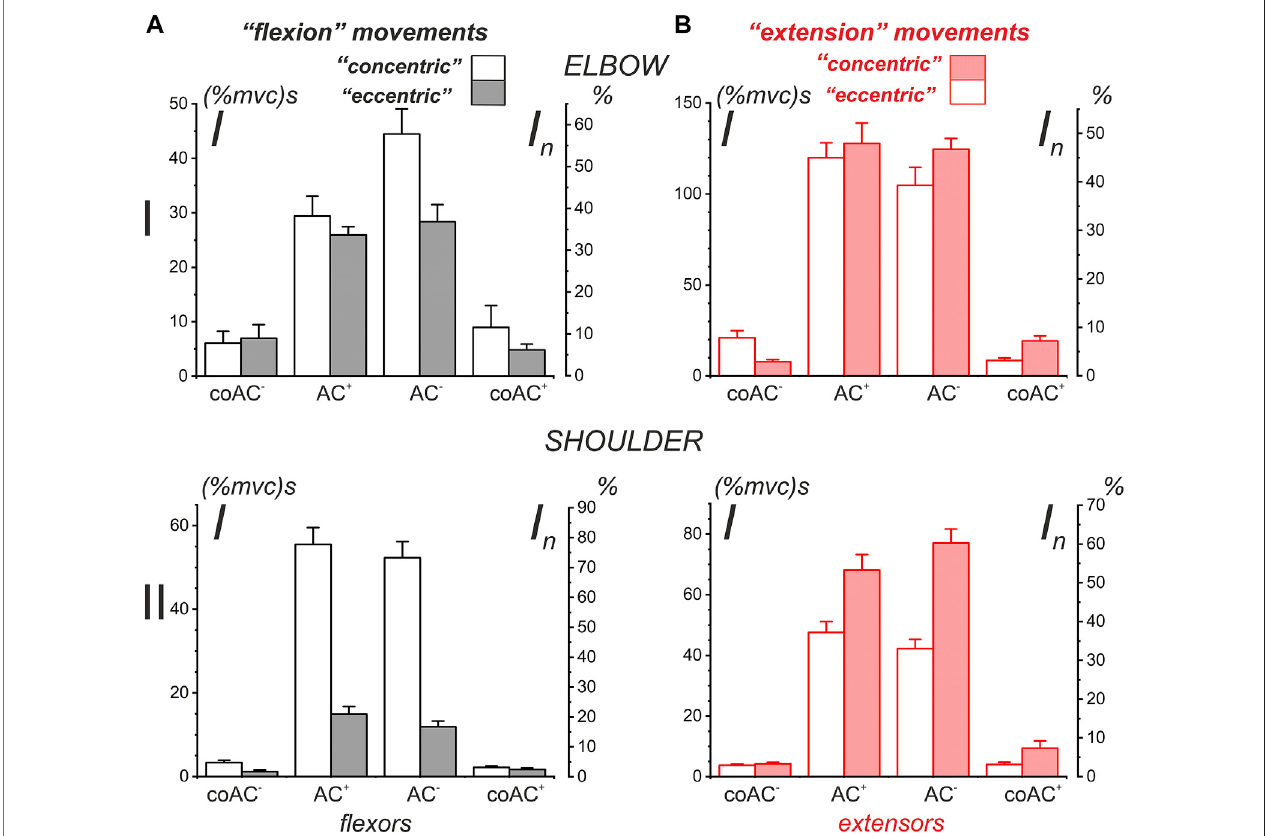
FIGURE 11 | Statistical analysis of the average EMG components recorded in four different experiments on a subject with identi fi ed bone geometry (YK). This is a partial representation in graphical form of the quantitative data from Table 1 . The additional scales I n (%) on the right side of the plots represent the percentage normalization of the statistical parameterswith respect to the sum of themeans ofall presented components inthe plots. Note that the order ofcomponentsin the plots along their X -axes coincides with the sequence of their appearance in the corresponding test movements.